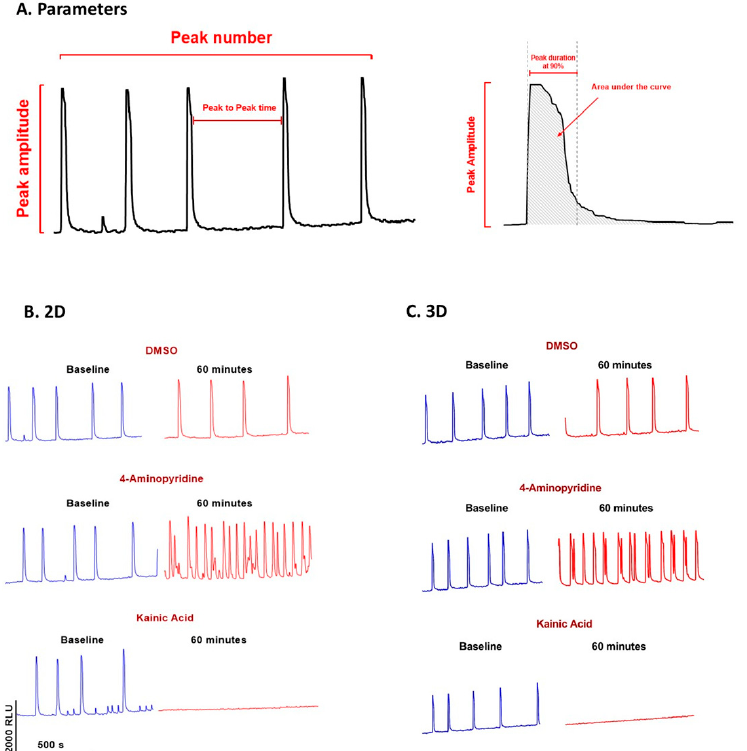
Figure 2. Examples of Ca 2+ -transient recordings. ( A ) Following parameters were measured as indi- cated: Ca 2+ peak amplitude, peak count (peak number or account/10 min), pulse width, area under curves, and peak-to-peak interval. ( B , C ) The effects of 0.1% DMSO, 30 µ M of 4-Aminopyridine and 100 µ M of Kainic Acid on hiPSC-derived neurons cultured in 2D ( left ) and 3D ( right ) conditions with human primary astrocytes are shown. The traces are at around 60 min after the drug